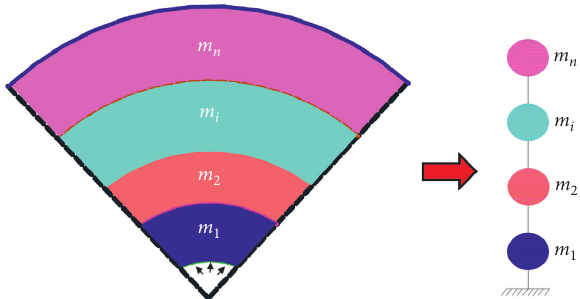
Figure 4: Multidegree freedom model of blasting vibration of layered rock